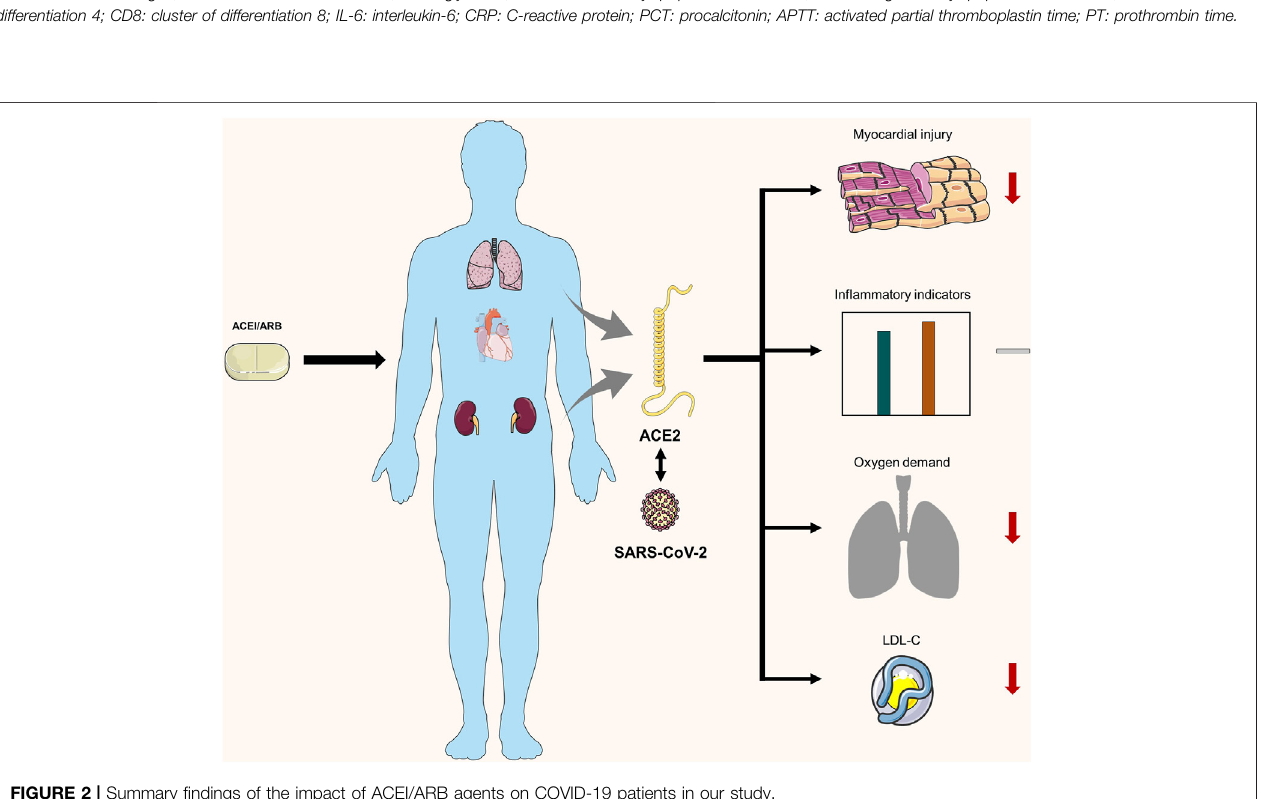
FIGURE 2 | Summary fi ndings of the impact of ACEI/ARB agents on COVID-19 patients in our study.